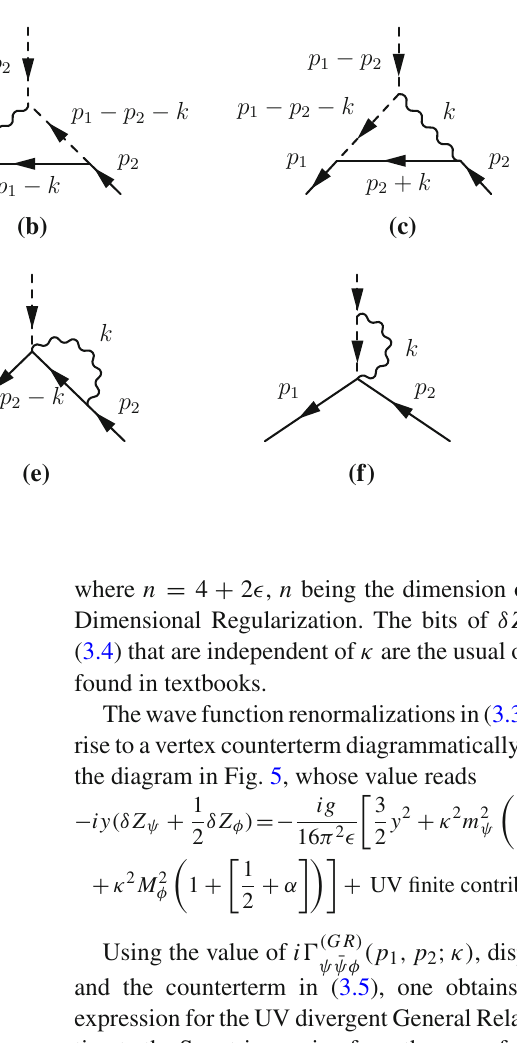
Fig. 4 Vertices of order y 2 κ